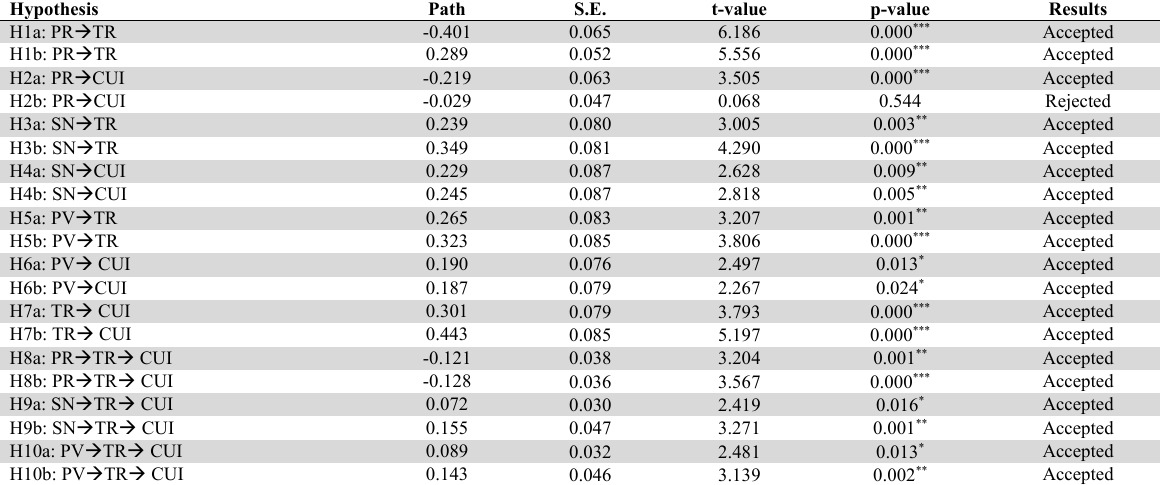
Fig. 2 the hypothesis testing of the structure model found that out of 20 hypotheses tested for the structural model, a total of 19 hypotheses were accepted, and a total of 1 were rejected. However, the primary evaluation criteria for the structural model were the R² measures, with values of between 0.431-0.634, which were at a moderate level. Therefore, all hypothesis testing results can be considered in more detail in Table